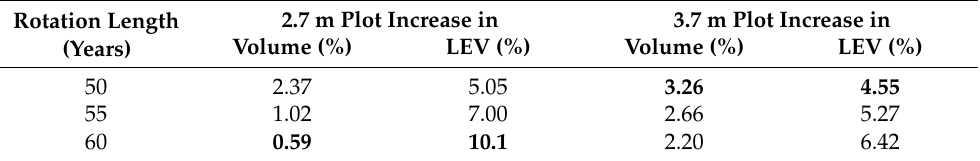
Table 5. Changes in merchantable volume harvested and increases of median LEVs relative to the reference prescription from use of heuristic tree selection on the 2.7 and 3.7 m plots. The reference prescription was not valid for the Nelder plot, other rotation lengths, or other thinning ages.